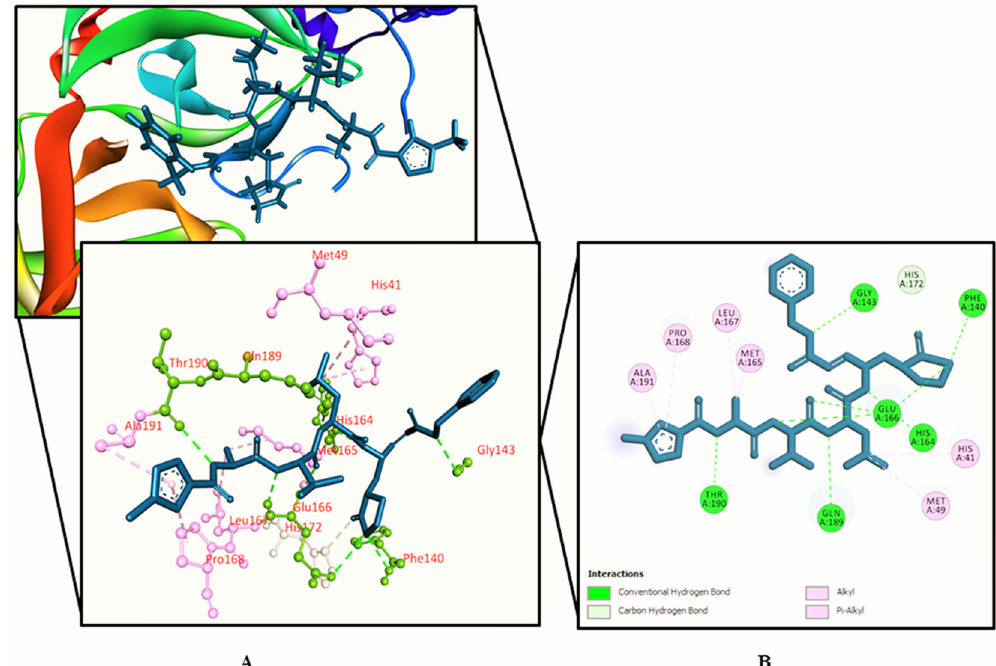
Figure 5. Standard inhibitor N3 binding the SARS-CoV-2 receptor (PDB ID: 6LU7). ( A ) A 3D representation and ( B ) 2D representation. Hydrogen bonds are displayed as green balls and sticks, hydrophobic bonds (Pi–Pi/Pi–sigma/amide–Pi interactions) are displayed as violet balls and sticks, hydrophobic bonds (Pi–alkyl/alkyl interactions stacking) are displayed as pink balls and sticks, hydrophobic bonds (Pi–sulfur) are displayed as gold balls and sticks, and carbon–hydrogen bonds are displayed as white balls and sticks.